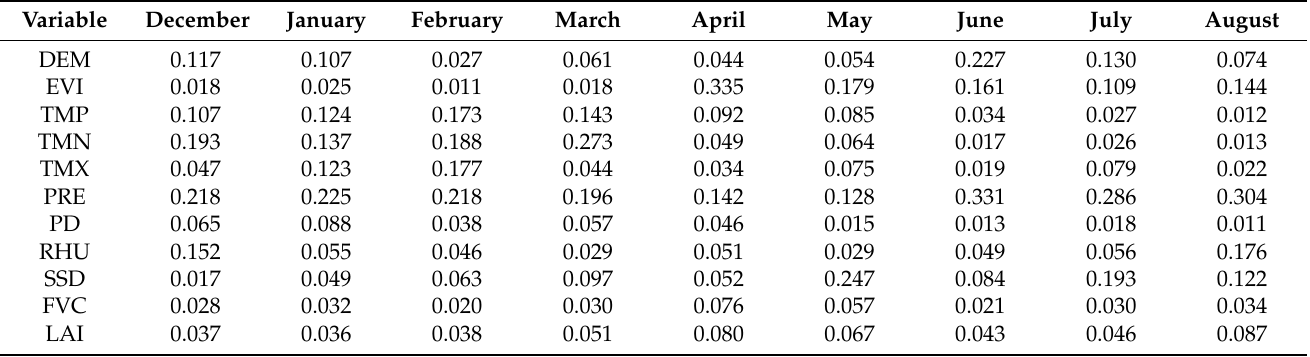
Table 1. The Gini importance of variables for each